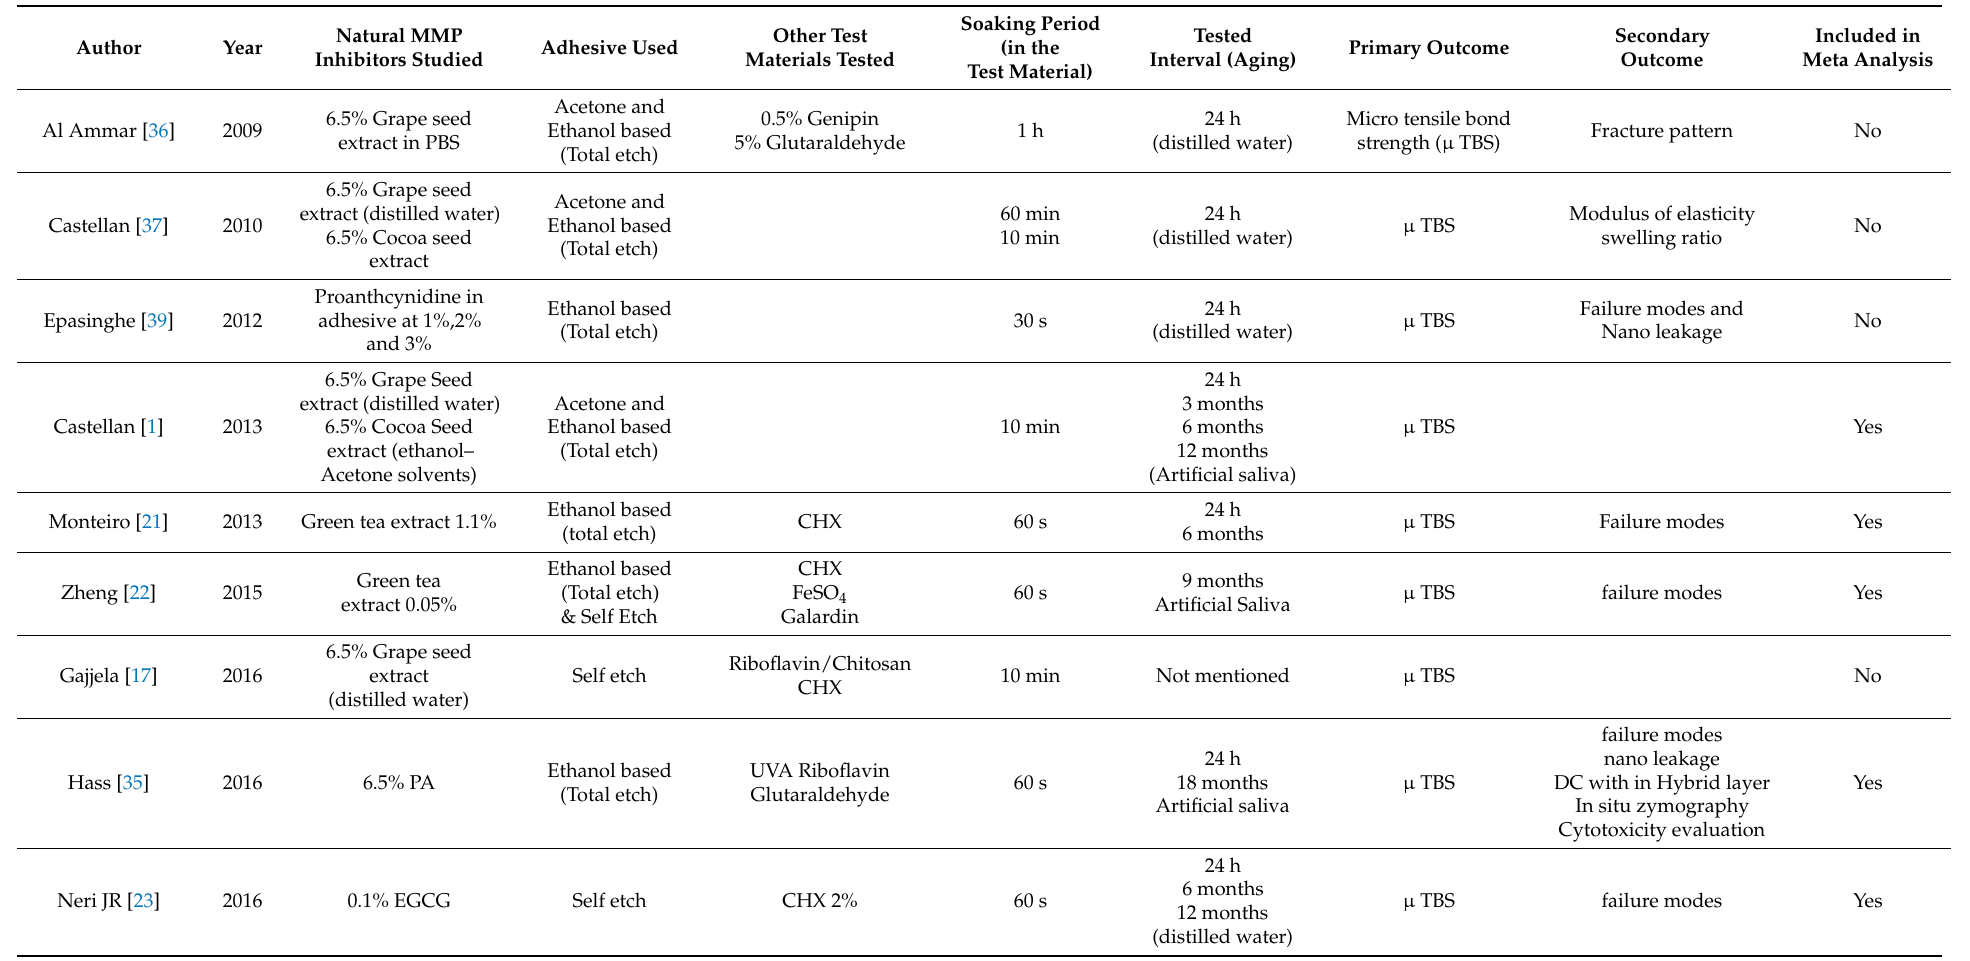
Table 2. The characteristics of in vitro studies